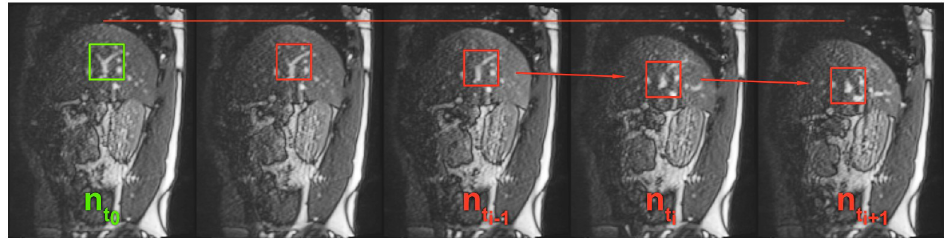
Fig 6. Out-of-plane motion and template updates. The figure shows a series of navigator slices. The green rectangle denotes a typical ROI that was manually determined as a template. In the red rectangles, one can see how the vessel cross-section changes its appearance during the breathing cycle. For viewing purposes only, the images gradation curve was altered globally to enhance contrast.